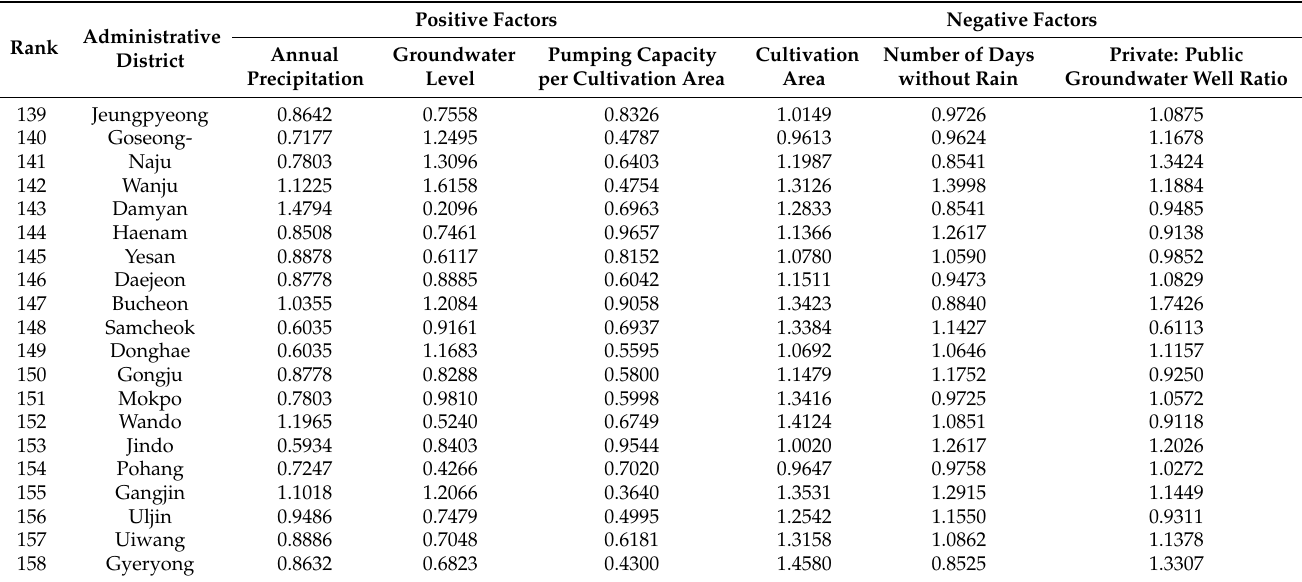
Table 5. Ranking of the 20 districts with the least